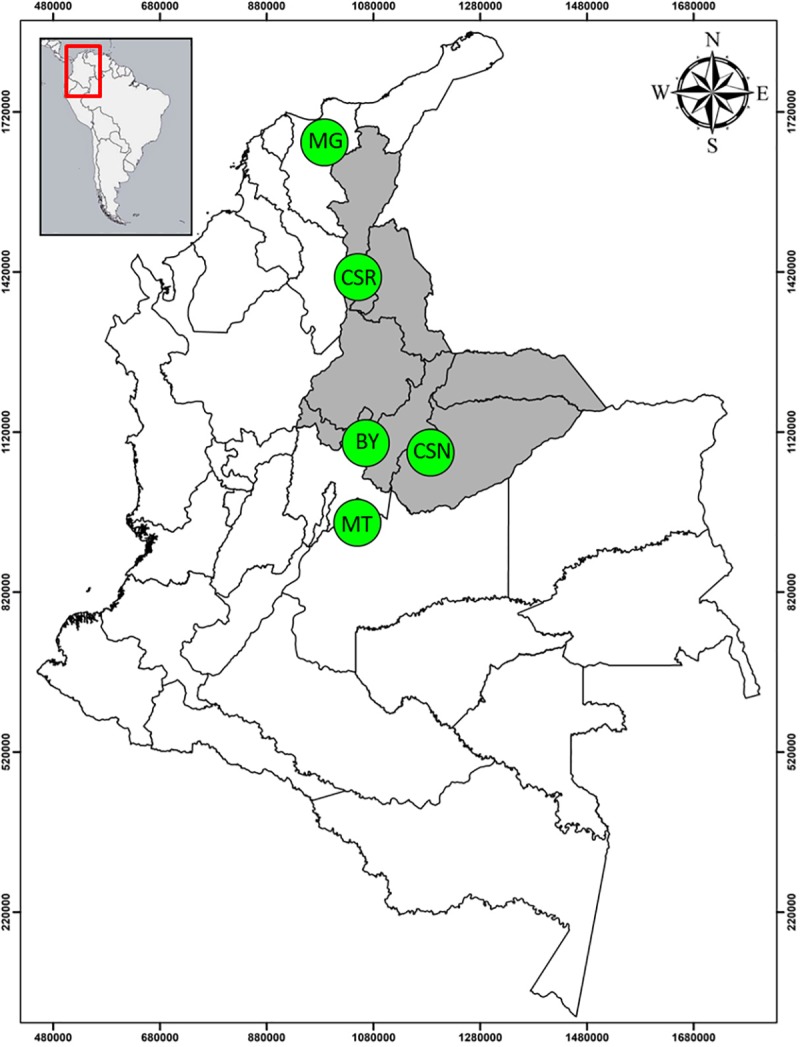
Sampling map in active military population of The Colombian National Army gathered in five departments during 2018.A total of 295 individuals were sampled in five BITER as described below: Boyacá or BY (N = 46), Casanare or CSN (N = 66), Cesar or CSR (N = 65), Magdalena or MG (N = 55) & Meta or MT (N = 63). In gray are highlighting the most endemic areas for Chagas disease according to The National Institute of Health in Colombia. These endemic areas were used as inclusion criteria for sampling the military personnel in this study.